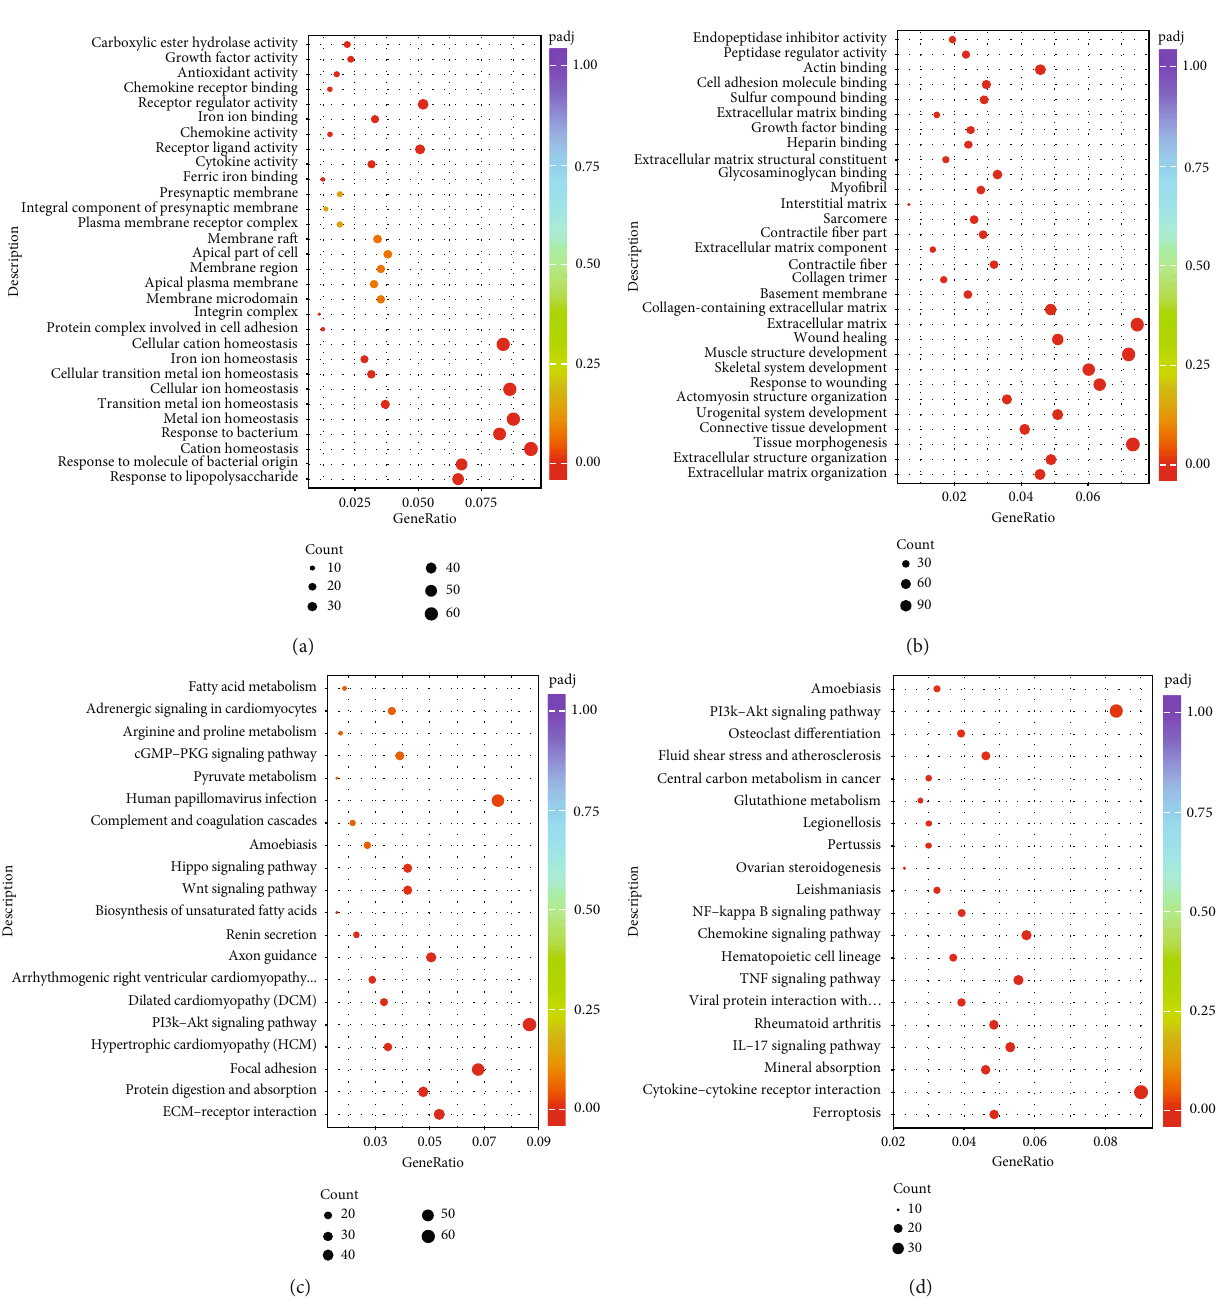
Figure 3: GO and KEGG enrichment analysis of DEGs. (a) GO enrichment analysis of down-DEGs. (b) GO enrichment analysis of reversed down-DEGs. (c) KEGG enrichment analysis of down-DEGs. (d) KEGG enrichment analysis of reversed down-DEGs. The horizontal coordinates are the ratio of the number of DEGs to the total number of DEGs that are annotated to GO/KEGG terms, and the vertical coordinates are the GO/KEGG